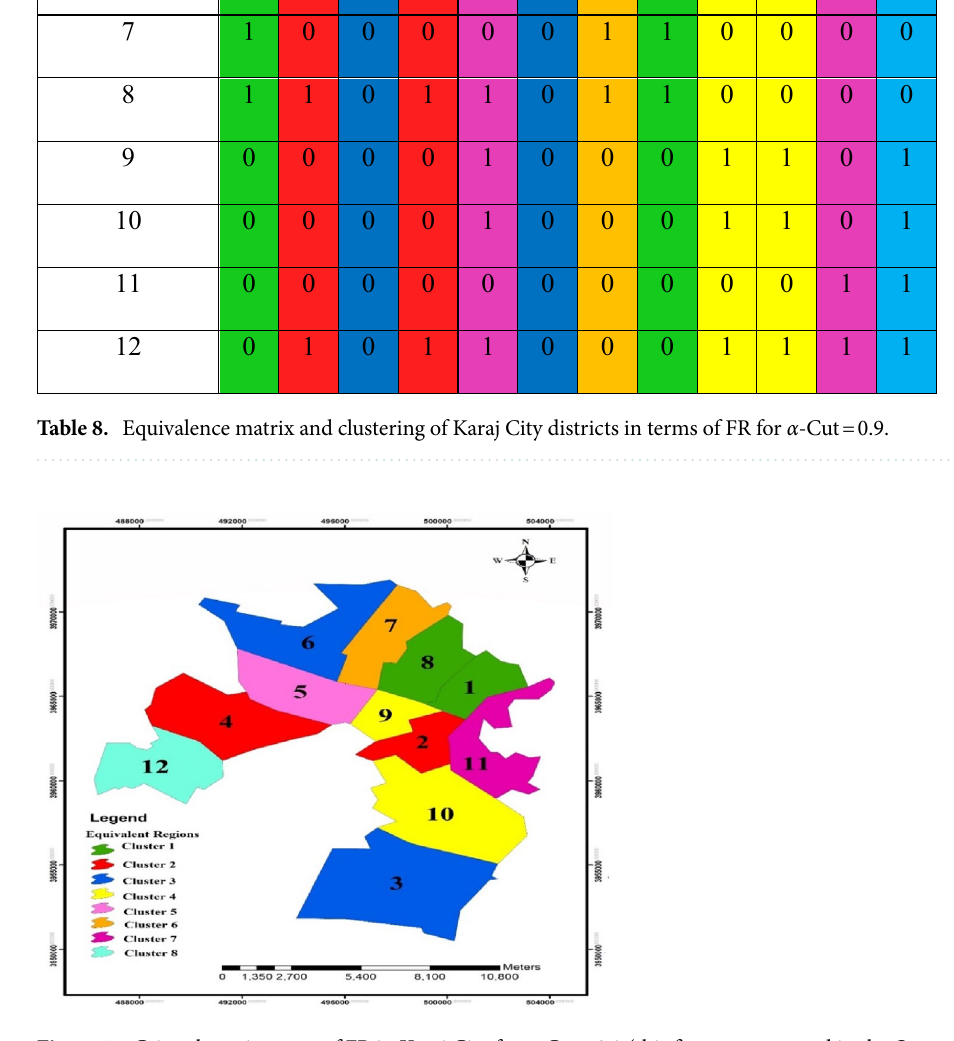
Figure 5. Crisp clustering map of FR in Karaj City for α -Cut = 0.9 (this figure was created in the Quantum GIS, version